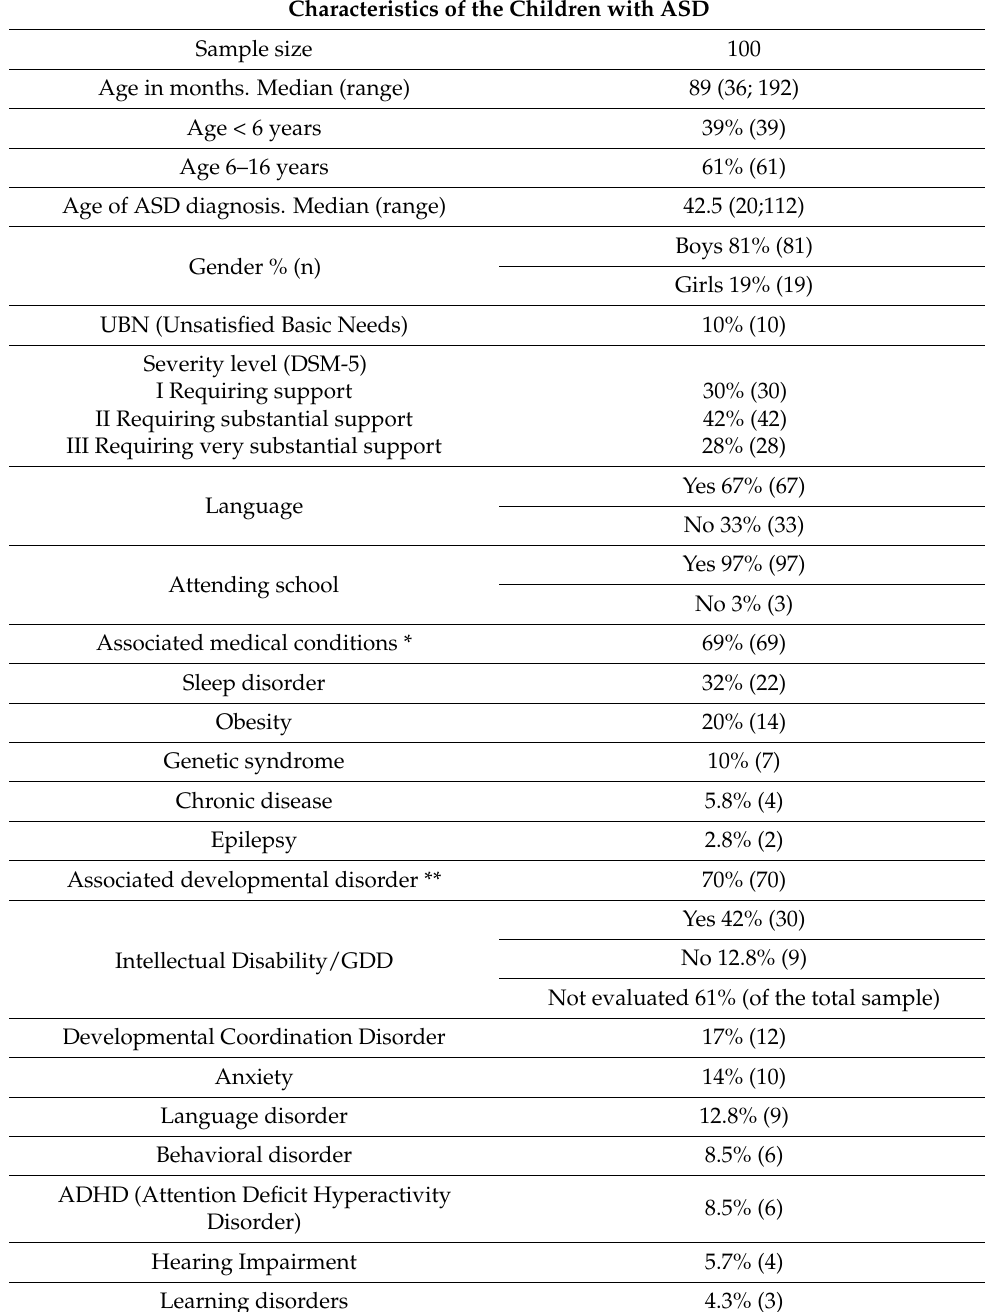
Table 2. Characteristics of the sample using TEA-CIFunciona version